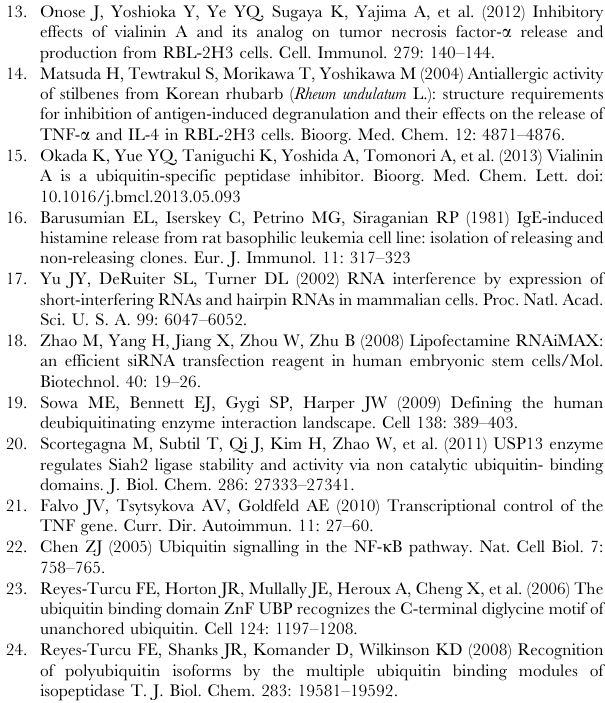
Figure S1 Effect on b -hexosaminidase release from DUB siRNA-knockdown cells. Amounts of b -hexosaminidase